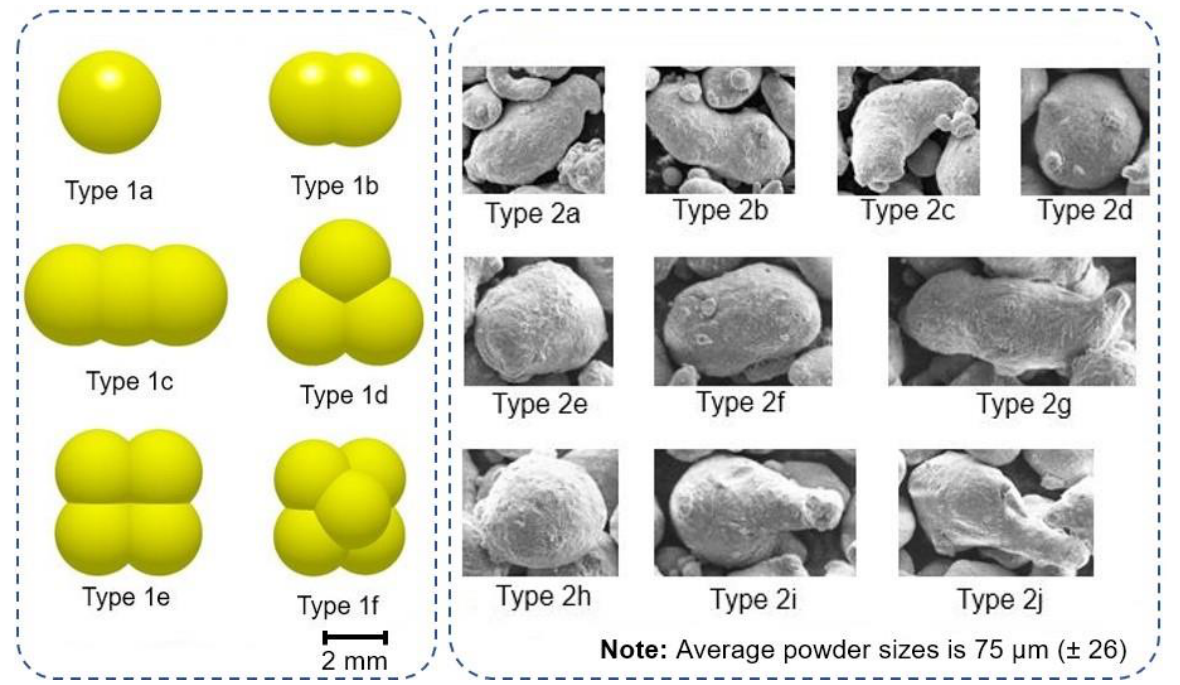
Figure 3. Commonly used particle morphologies in literature (Type 1 series) and the most representative particles for SEM photos of the real powders (Type 2 series).